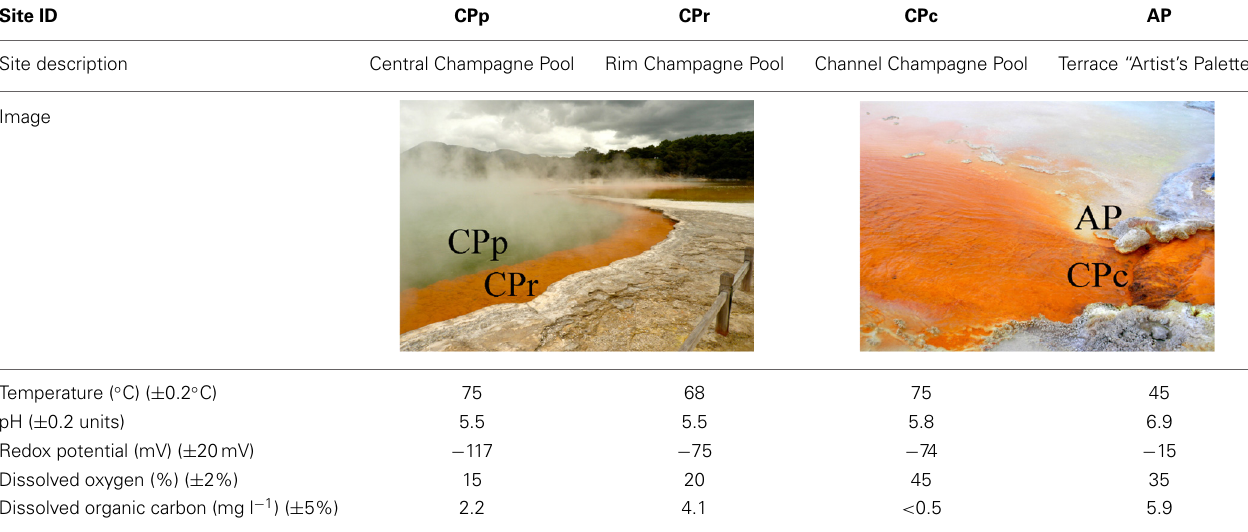
Table 1 | Temperature, pH, dissolved oxygen (DO) saturation, redox potential (Eh) and dissolved organic carbon (DOC) concentration in Champagne Pool.